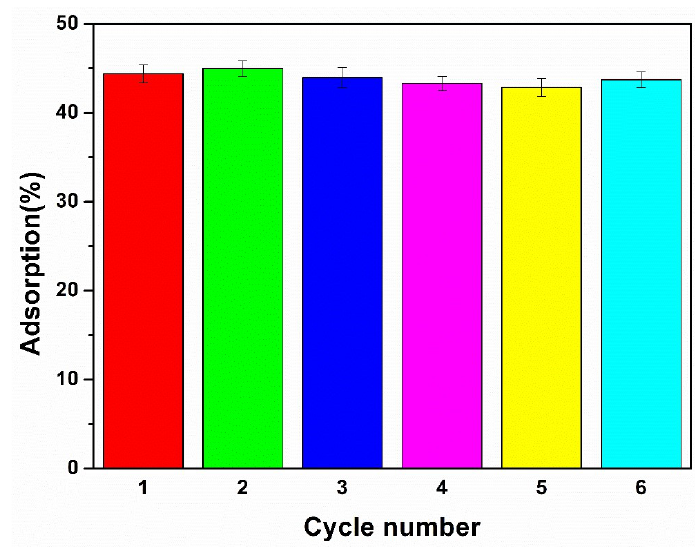
Figure 9. Recycling of TA / GO for the removal of U(VI) ions (C initial = 7.0 × 10 − 4 M, pH = 3.6 ± 0.05, m / V = 0.6 g / L, T = 298 K).